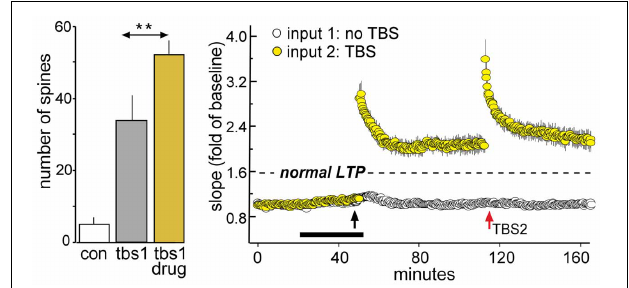
FIGURE 8 | Enhancing LTP1 blocks further increases in potentiation with a second round of TBS. Theta burst stimulation (TBS) was applied to the Schaffer-commissural afferents to field CA1b in adult rat hippocampal slices. Left : Counts of densely phalloidin-labeled spines in the CA1 field of afferent stimulation show that in the presence of the ampakine CX614 (drug), one round of theta burst stimulation (tbs1) significantly increases the numbers of spines containing this marker of potentiation above that induced by TBS alone ( ∗∗ p < 0 . 01). Right : Plot of field EPSPs shows that TBS1 (black arrow) applied in the presence of ampakine infusion (black bar) elicits an LTP effect that is about twice as large as that produced in the absence of the drug (indicated by dashed line) but a second TBS bout (TBS2, red arrow) elicits no further potentiation (in contrast to effects of TBS2 applied under control conditions; see Figure 7B ). Modified from Kramar et al.